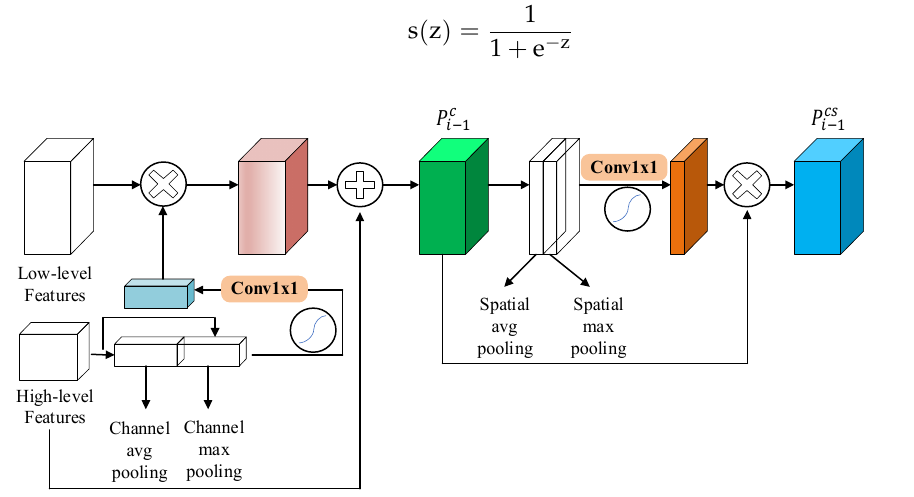
Figure 6. Schematic diagram of the attention mechanism fusion.